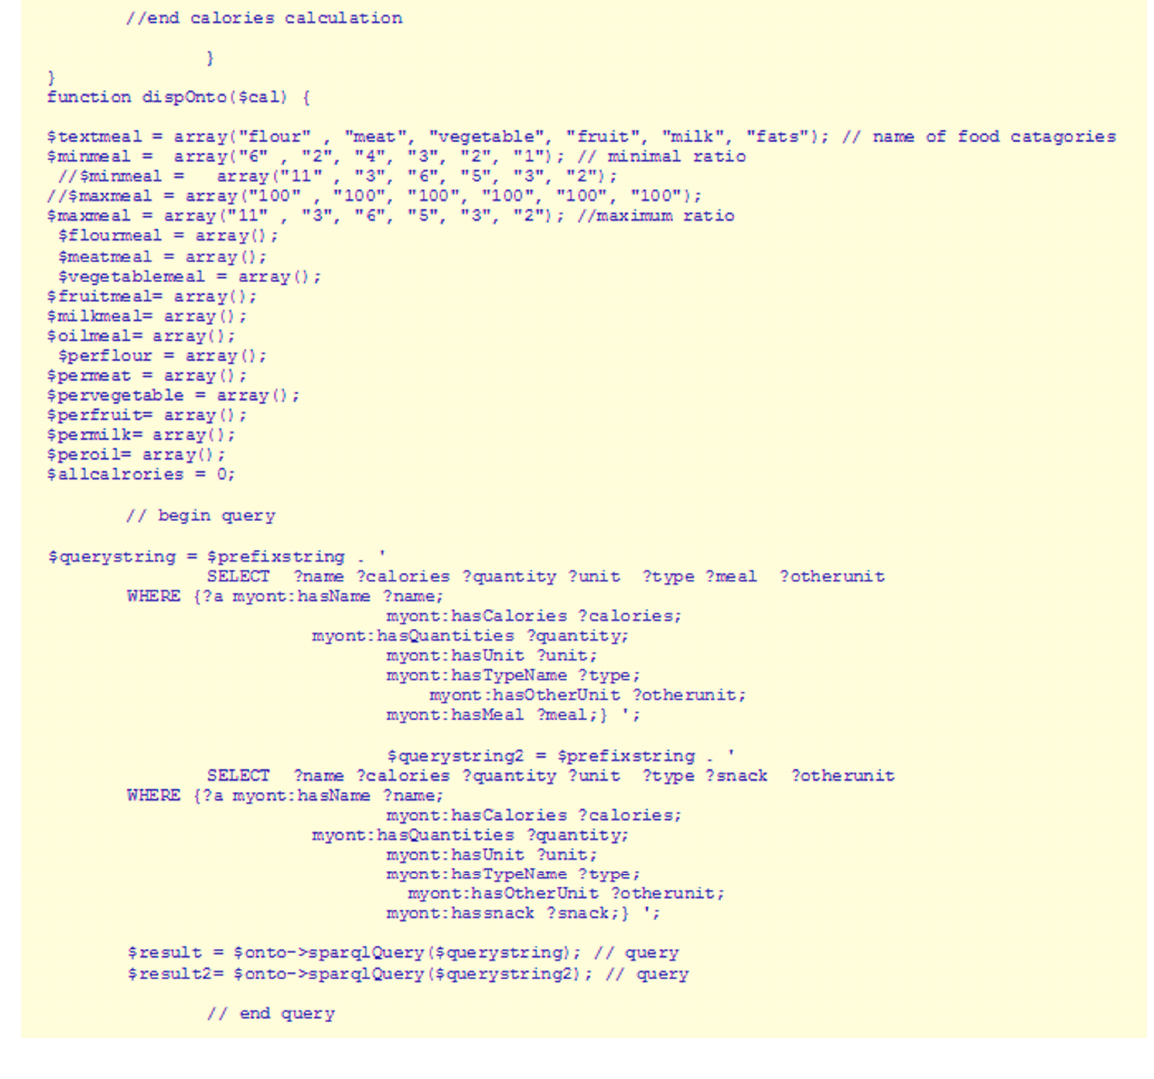
Figure 6. Code snippet showing the input and calories calculation process in FOODS—Diabetes